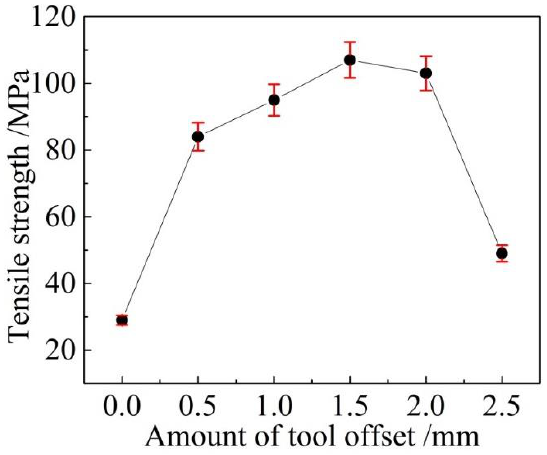
Figure 8. Tensile strength of the joints with different tool offset.